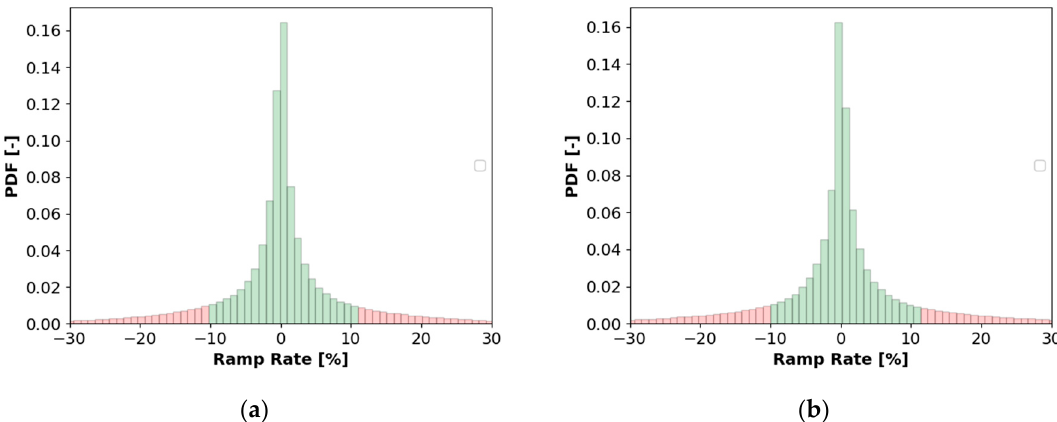
Figure 4. Probability Density Functions (PDF) of the ramp rates 1-min data: ( a ) wind turbine (WT) #1 ( b ) WT #2.